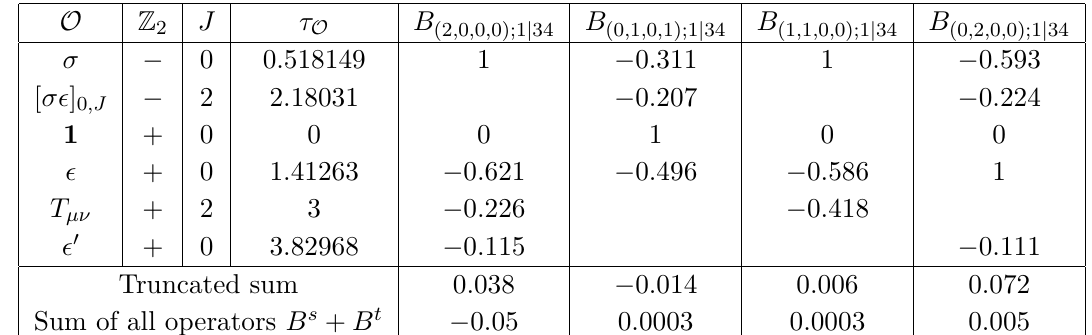
Table 9 . Contribution of each operator to the B functional acting on the h σσ(cid:15)(cid:15) i correlator with v = 1 ; these results include the contribution of the OPE coefficients f O presented as ratios of the individual operator relative to the largest contribution to the sum rule. Empty cells contribute at order O (10 − 2 ) and less.